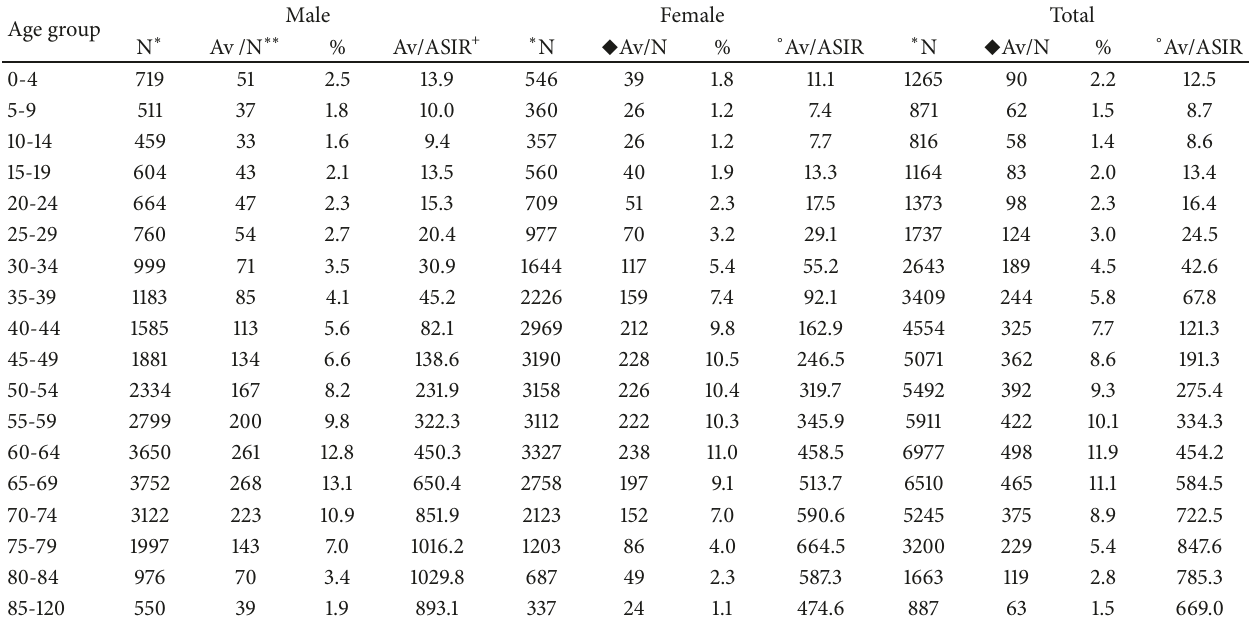
Table 2: Age specific incidencee rates of cancer among males and females in Jordan,